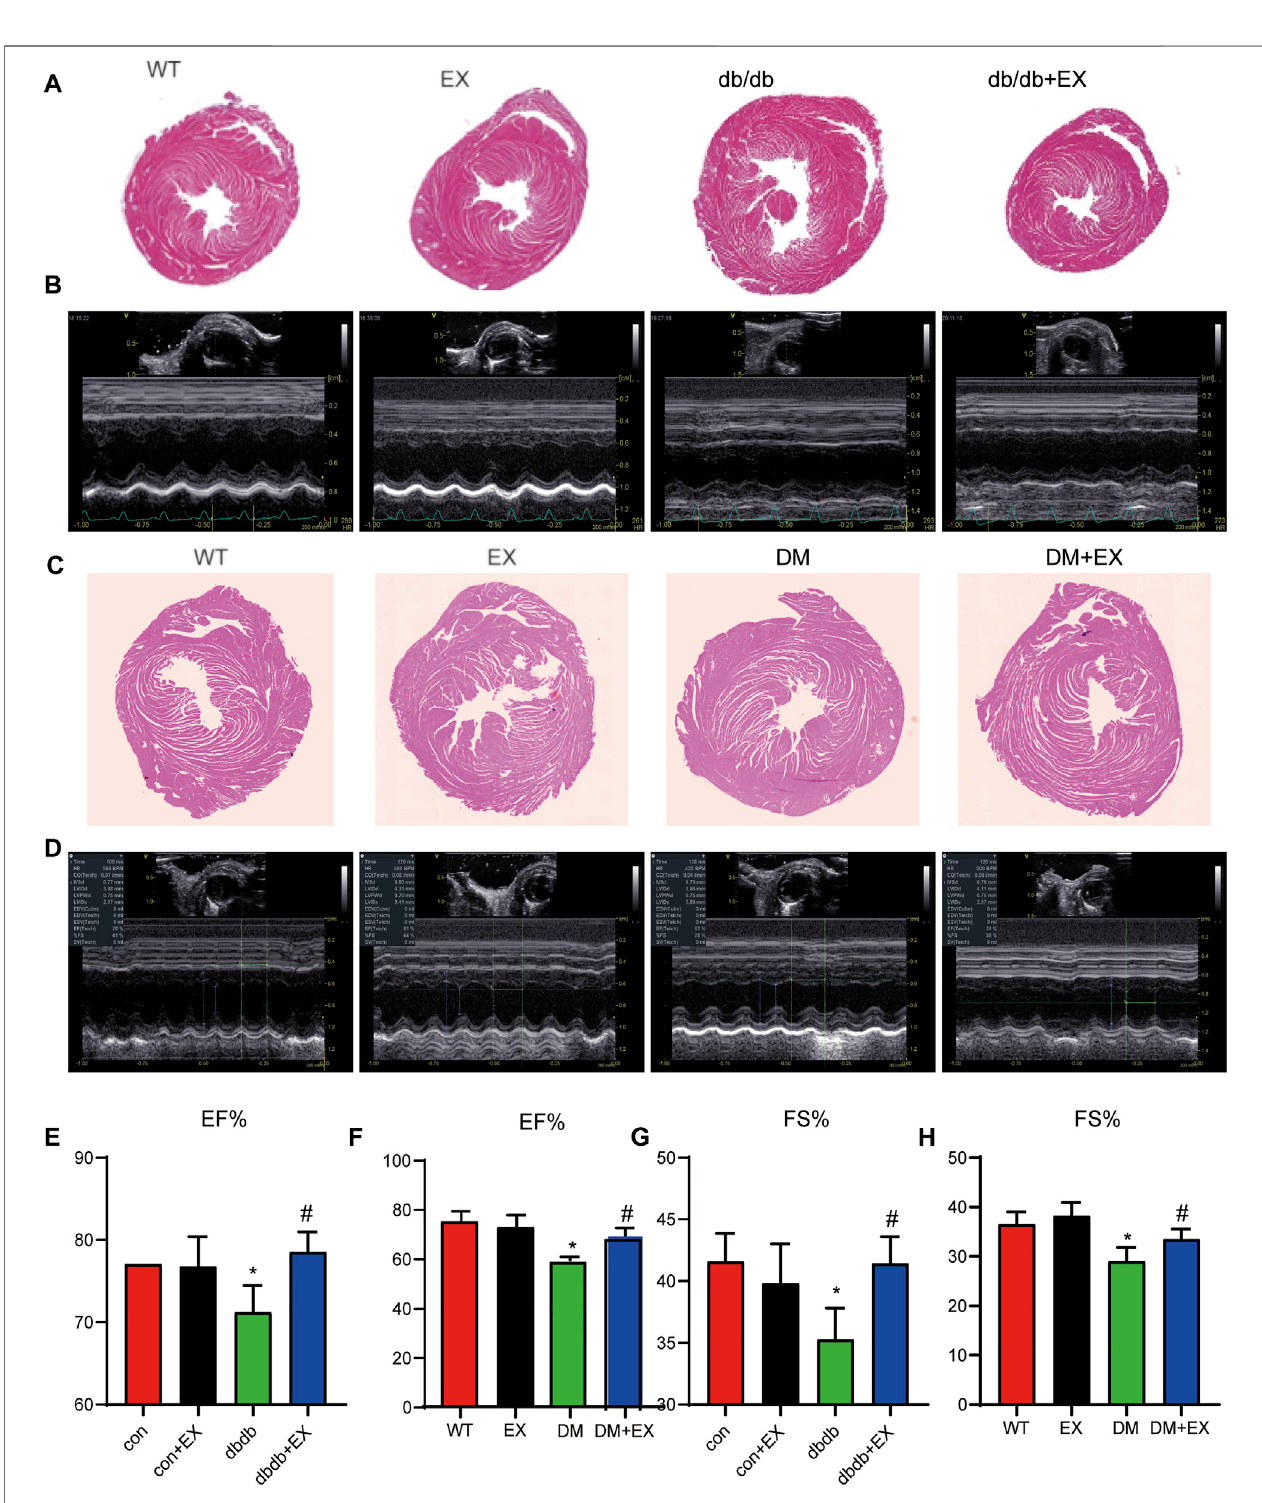
FIGURE 3 | Exercise improved heart function in db/db mice or DM mice. (A,C) Cardiac morphology after exercise in db/db or DM mice. (B,D) M-mode echocardiography in mice. (E – H) Cardiac function in mice. * p < 0.05 vs. the WT group, # p < 0.05 vs. the DM group. EF%: ejection fraction; FS%: fraction shortening.